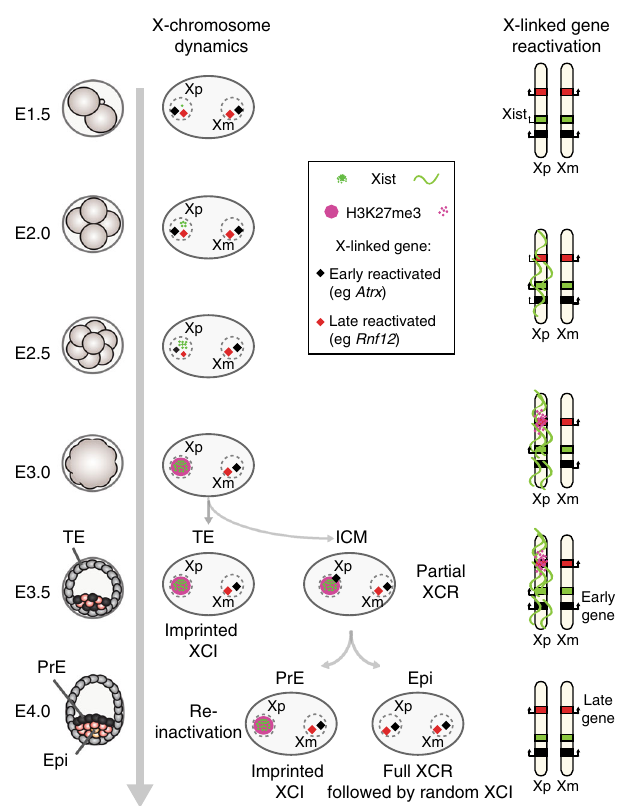
Fig. 6 Representation of Xp reactivation and different X-linked gene behaviours. Scheme of imprinted XCI, followed by reactivation in the ICM of the blastocyst. Xp silencing is triggered by the long non-coding Xist RNA, followed by H3K27me3 recruitment. At the early blastocyst stage (E3.5), imprinted Xp is maintained in TE, when some genes are already showing reactivation in the ICM, independently of Xist (early-reactivated genes). Those early genes are lowly enriched in H3K27me3 marks and highly enriched in H3K4me3 on their paternal allele compared to the later reactivated ones. A few hours later, when ICM cells are divided into PrE and Epi cells, Xp reactivation appears to be nearly complete only in the future epiblast cells, (based on loss of Xist coating and H3K27me3). In PrE,